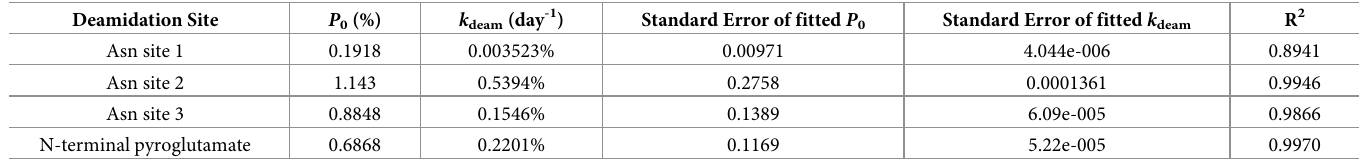
Table 1. The best-fit parameter values in the modification rate equations from the single-dose PK study. Deamidation